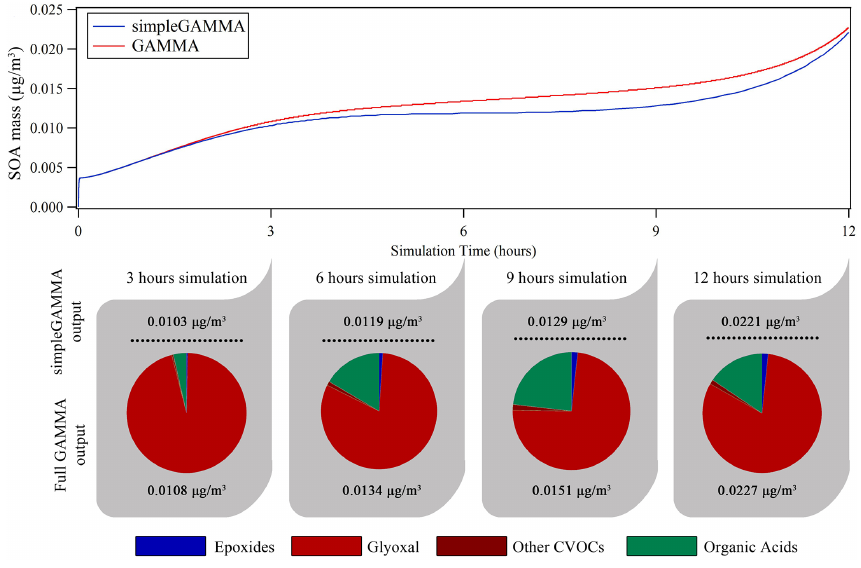
Figure 3. Comparison of high-NO x simpleGAMMA and the full high-NO x GAMMA, pH1, RH45%.